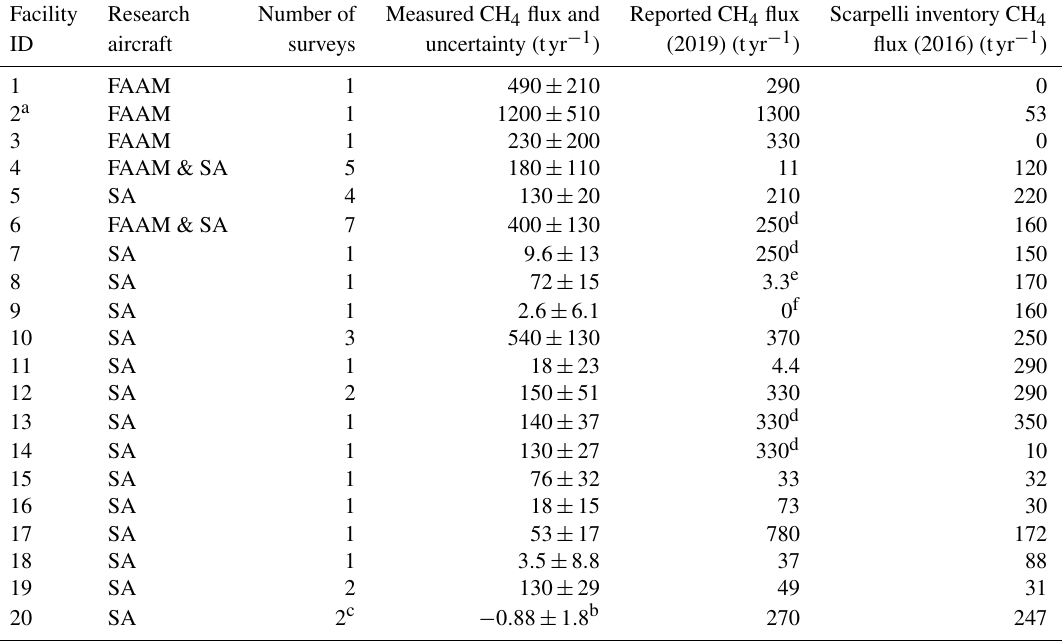
Table 1. Summary of the measured CH 4 fluxes and comparison with respective emission data from the Scarpelli et al. (2020) global inven- tory and reported CH 4 emissions from the O&G facility operators. All measured, reported and Scarpelli et al. (2020) inventory (Scarpelli inventory) fluxes are quoted to two significant figures here. Flux uncertainties represent confidence intervals of 1 standard deviation for each facility (see Sect. 3.2 for details). SA: Scientific